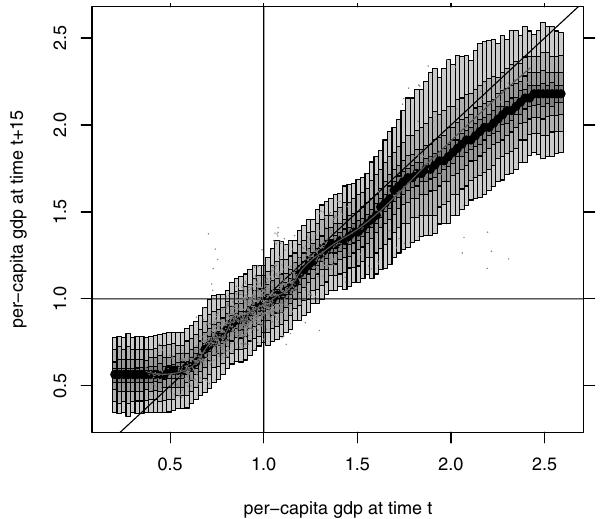
Figure 5 – Intra-Distribution Dynamics of regional per-capita income in Europe. HDR plot of conditional density for transitions of 15 years between 1980-2002. Estimates are based on a kernel density estimator with a variable bandwidth in the x direction (span = 0.15), a fixed bandwidth in the y direction (b = 0.127) and a mean function specified by a lowess smoother (span =